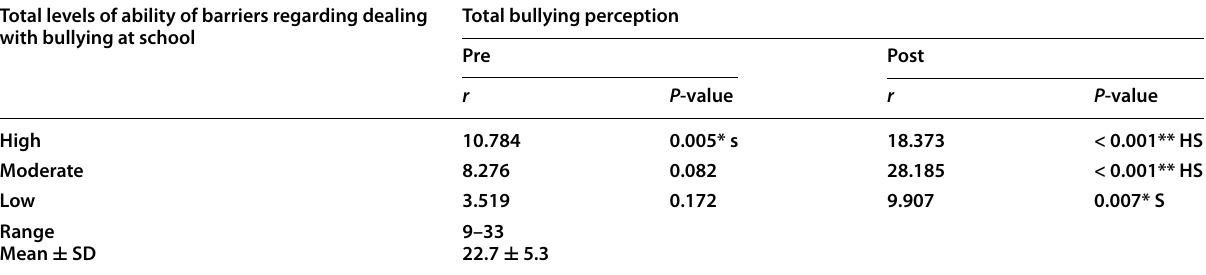
Table 4 Correlation between total levels of perceived barriers regarding dealing with bullying at school total bullying perceptions pre and post a psychoeducational intervention ( n =